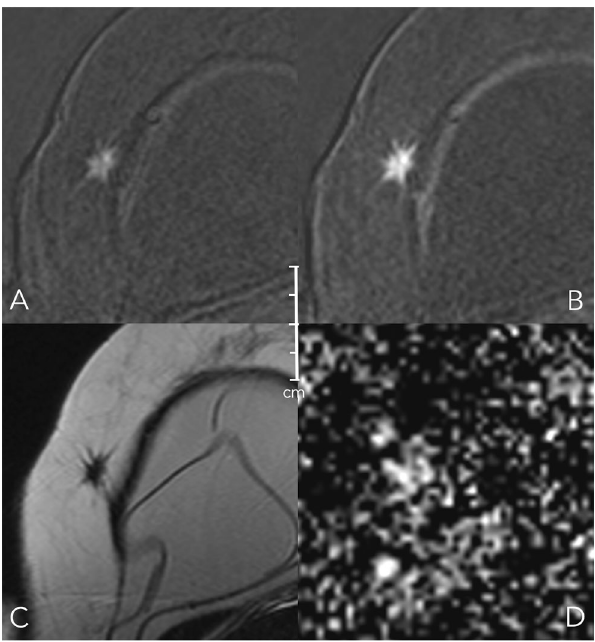
Fig. 11 Early (A) and delayed (B) contrast-enhanced subtractions, T2w (C), and ADC map (D). Mass lesion in the right breast of a 50-year-old female undergoing follow-up for breast cancer treatment. The lesion shows spiculations and a persistent enhancement curve type, corresponding to a Kaiser score of 6 (Fig. 6). T2w signal intensity is low (C) and ADC is decreased (0.8*10 -3 mm 2 /s). Histopathology revealed recurrent invasive ductal cancer G2, B5b